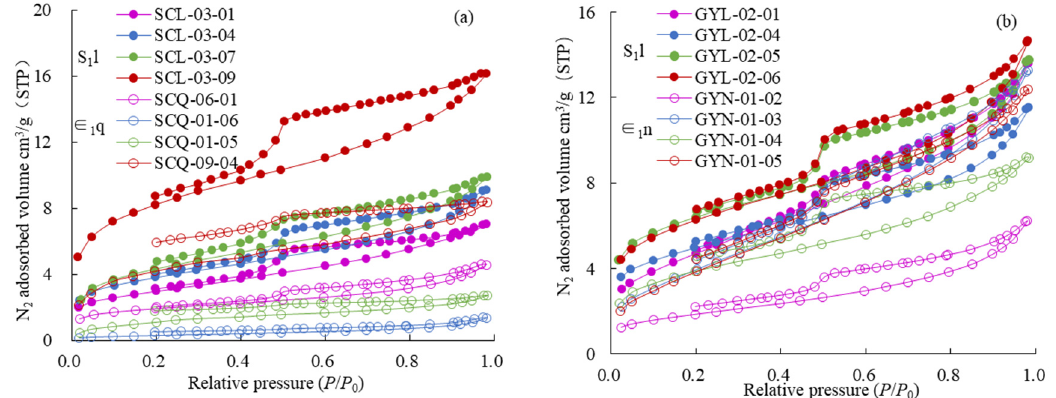
Figure 6. N 2 adsorption isotherms of the Lower Paleozoic shales in southern Sichuan Basin ( a ) and northern Guizhou province ( b ). (S 1 1 = the Lower Silurian Longmaxi Fm, ∈ 1 q = the Lower Cambrian Qiongzhusi Fm, ∈ 1 n = the Lower Cambrian Niutitang Fm).